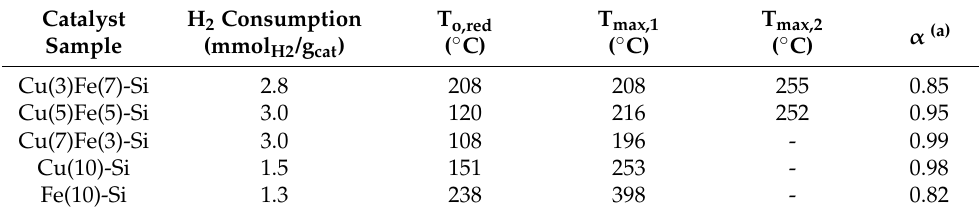
Table 2. Quantitative data from H 2 -TPR